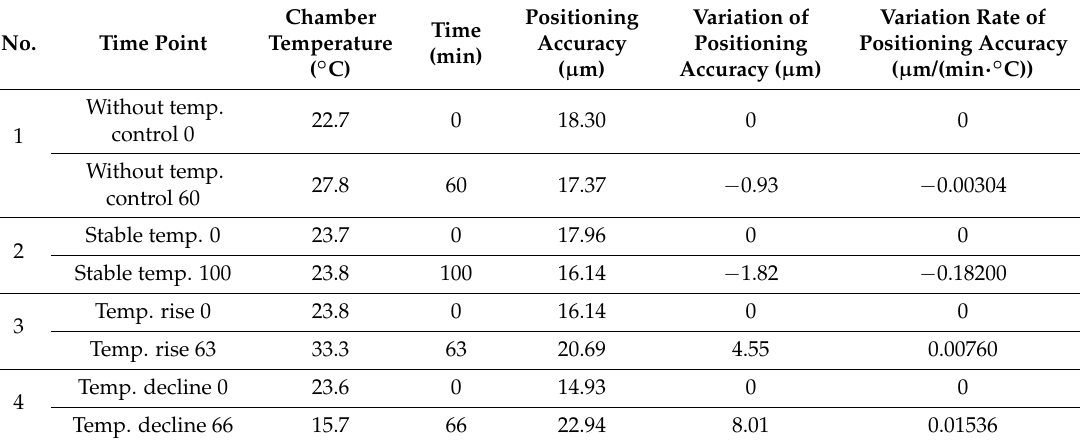
Table 1. Corresponding positioning accuracy of the periodically-moving carrier under stable temperatures, a rise in temperature, and a decline in